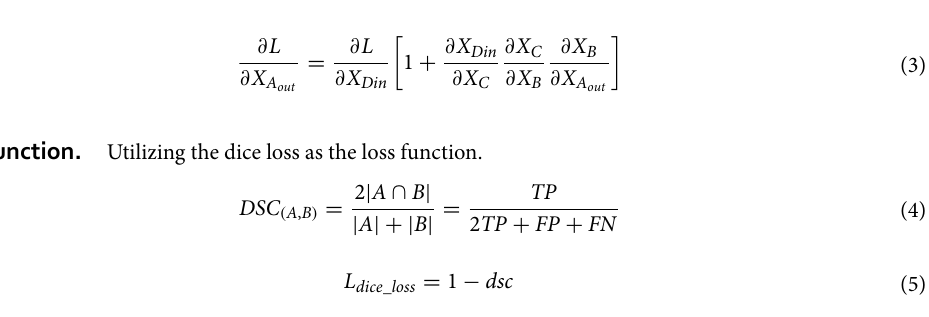
Figure 2. The architecture of U-Net with EfficientNet-b4